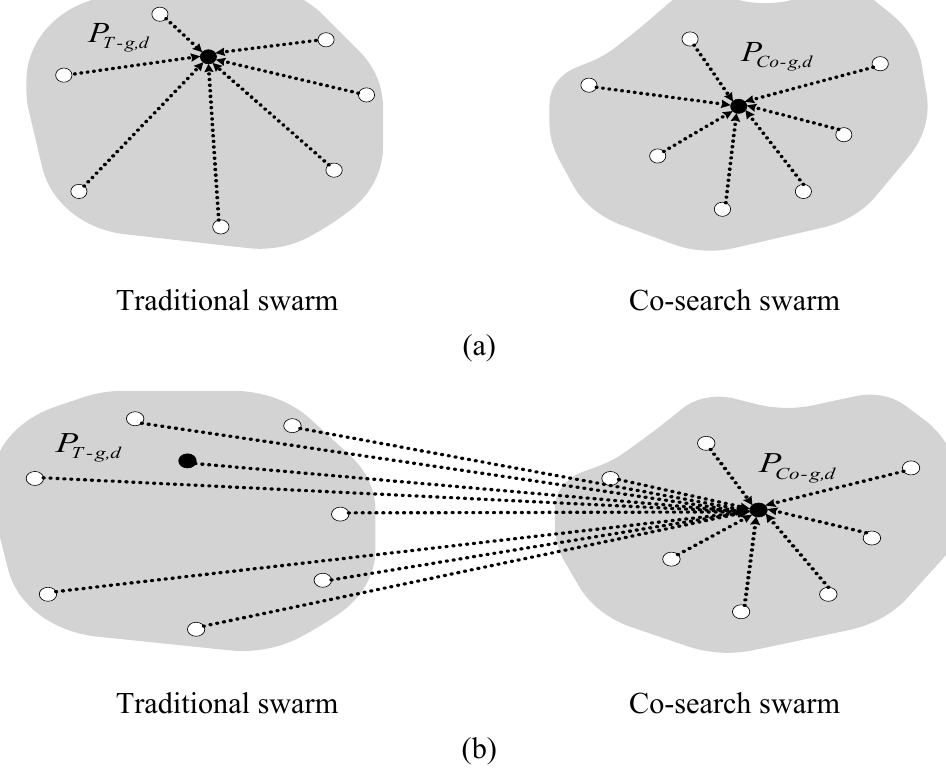
Figure 2. Diagram illustrating the two swarms’ convergence situations: ( a ) If f ( P Co − g , d ) ≥ f ( P T − g , d ) , ( b ) If f ( P Co − g , d ) < f ( P T − g , d )